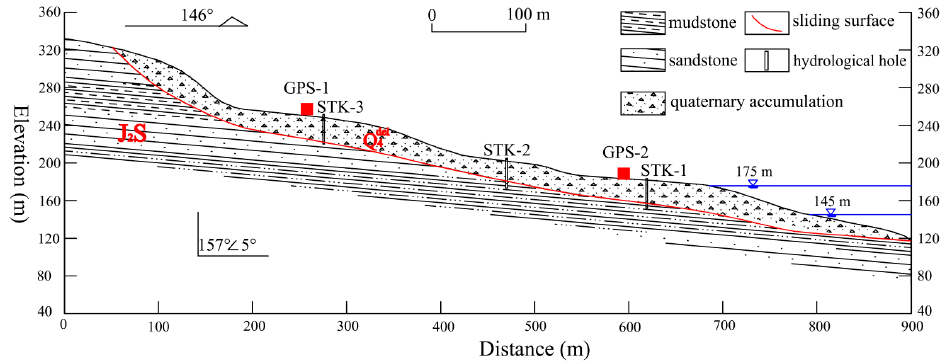
Figure 2. Geological cross-section of the Sifangbei landslide.